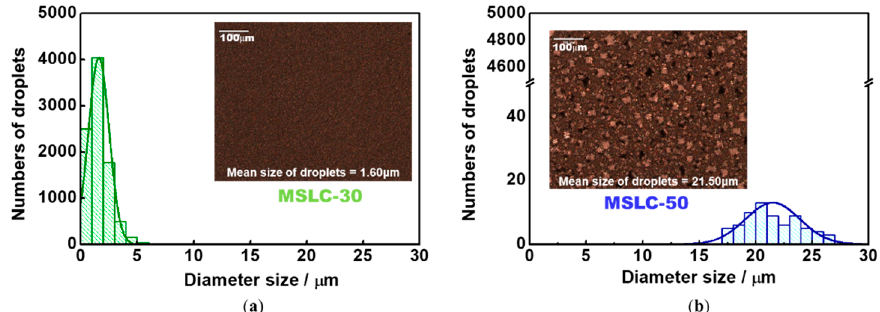
Figure 5. Histograms of the LC droplet size distribution in the MSLC-30 and MSLC-50 films, respectively. Typical POM images of the two films are also provided in the insets.